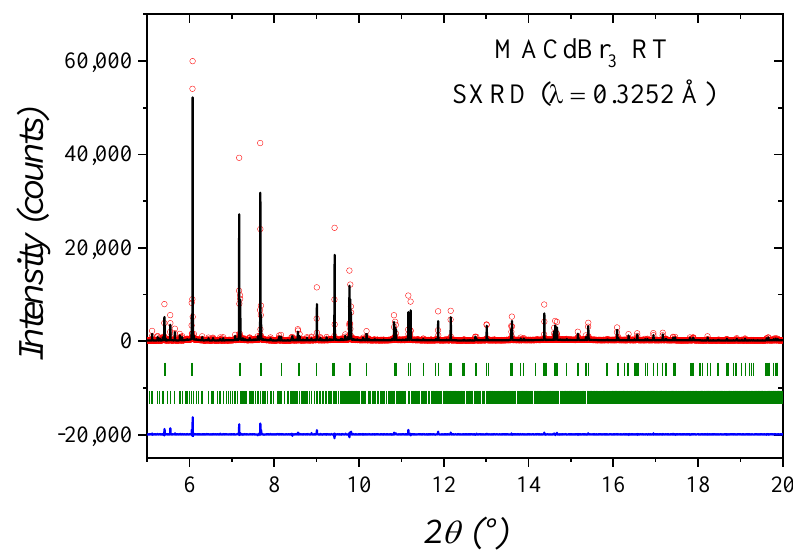
Figure 2. SXRD profiles for CH 3 NH 3 CdBr 3 at RT. The experimental points are represented by red circles, while calculated profile is a black full line and the blue lower line is the difference. The first series of green markers correspond to the allowed Bragg positions for the main phase ( Cmc 2 1 space group). The second series of markers corresponds to a minor impurity MA 2 CdBr 4 , ( P 2 1 / c space group).